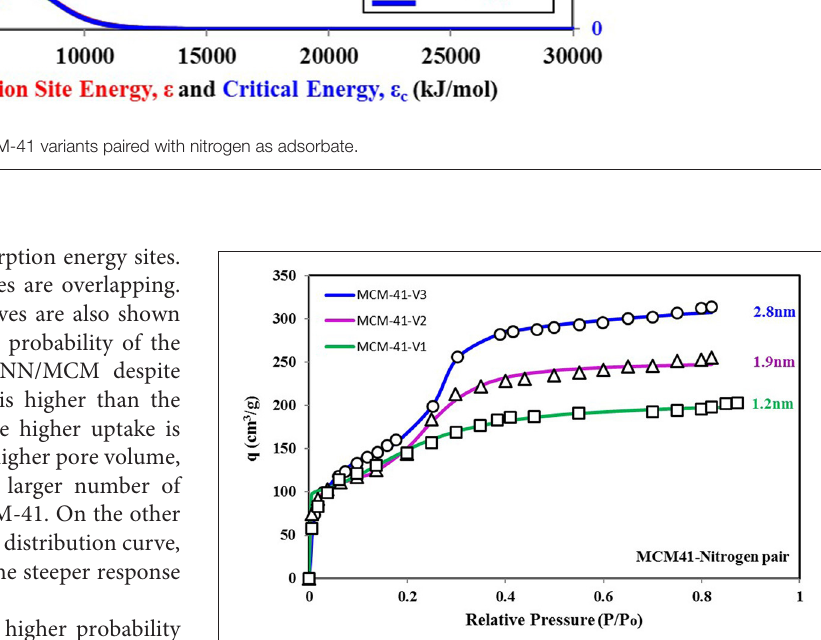
FIGURE 7 | Isotherms for MCM-41 V1, V2, and V3 variants with pore expansion when paired with nitrogen as the adsorbate. The pore expansion caused an increase in uptake. However, the response of the material against relative pressure shifted from smooth to sharp uptake. This transition can be explained from the energy distribution plot, where availability of median energy level is increasing with pore expansion, causing a sharp uptake when the ε c value goes lower than the median energy